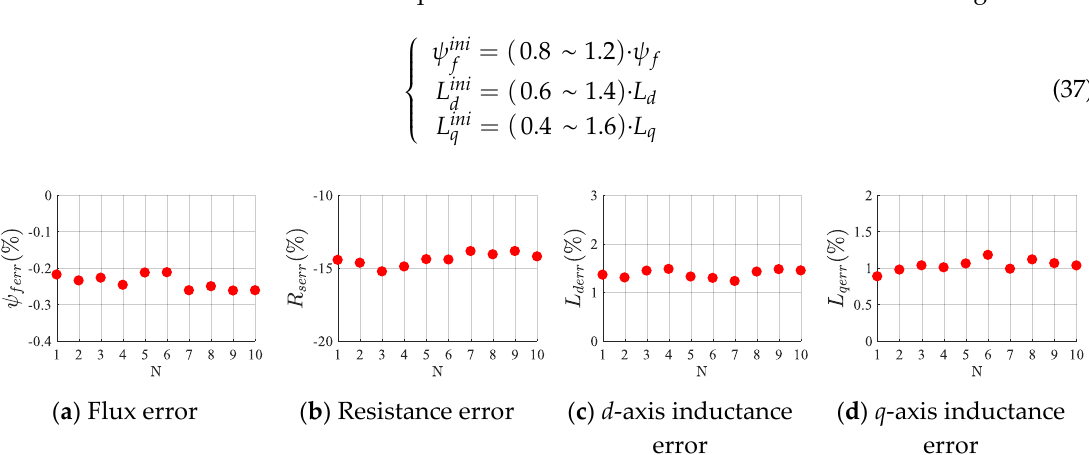
Figure 9. Experimental results at different speeds with different torques.